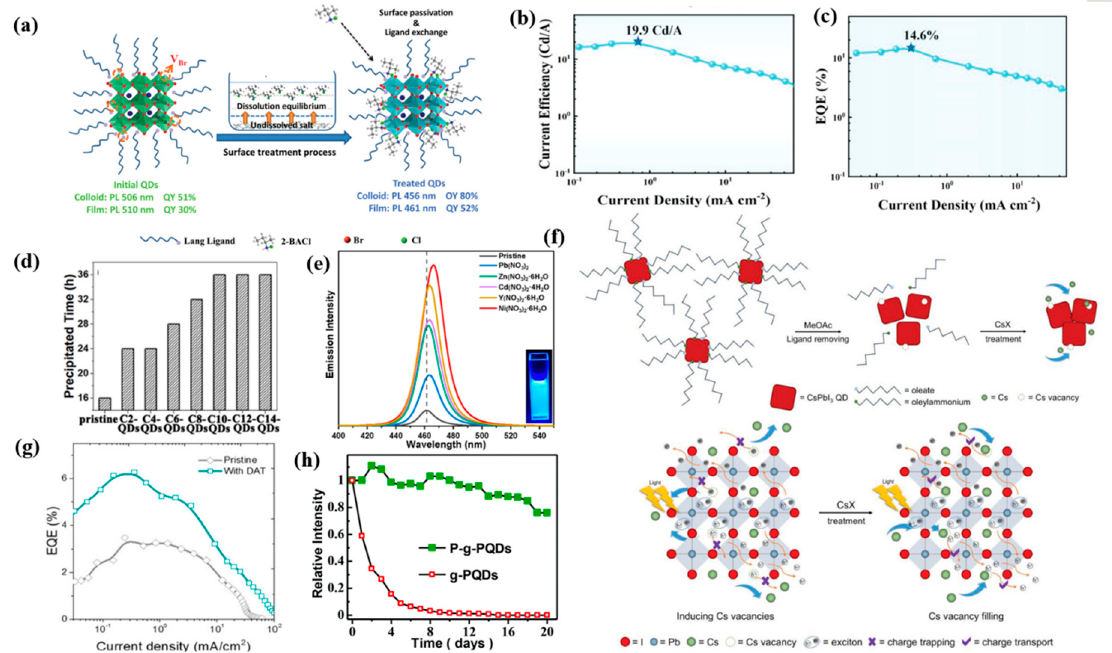
Figure 5. ( a ) Schematic of the surface regulation process. Reproduced with permission from Ref. [98]. Copyright Wiley, 2020. ( b ) The curve of the current efficiency of the device; ( c ) EQE of the devices based on the exchange QDs. Reproduced with permission from Ref. [48]. Copyright Wiley, 2022. ( d ) The precipitation times of the hexane solutions of all the samples. Reproduced with permission from Ref. [99]. Copyright Elsevier, 2021. ( e ) PL spectra. Reproduced with permission from Ref. [101]. Copyright American Chemical Society, 2019. ( f ) Schematic illustrations of CsPbI 3 QD film deposition and CsX post–treatment process. Reproduced with permission from Ref. [102]. Copyright Wiley, 2019. ( g ) EQE–current density. Reproduced with permission from Ref. [31]. Copyright